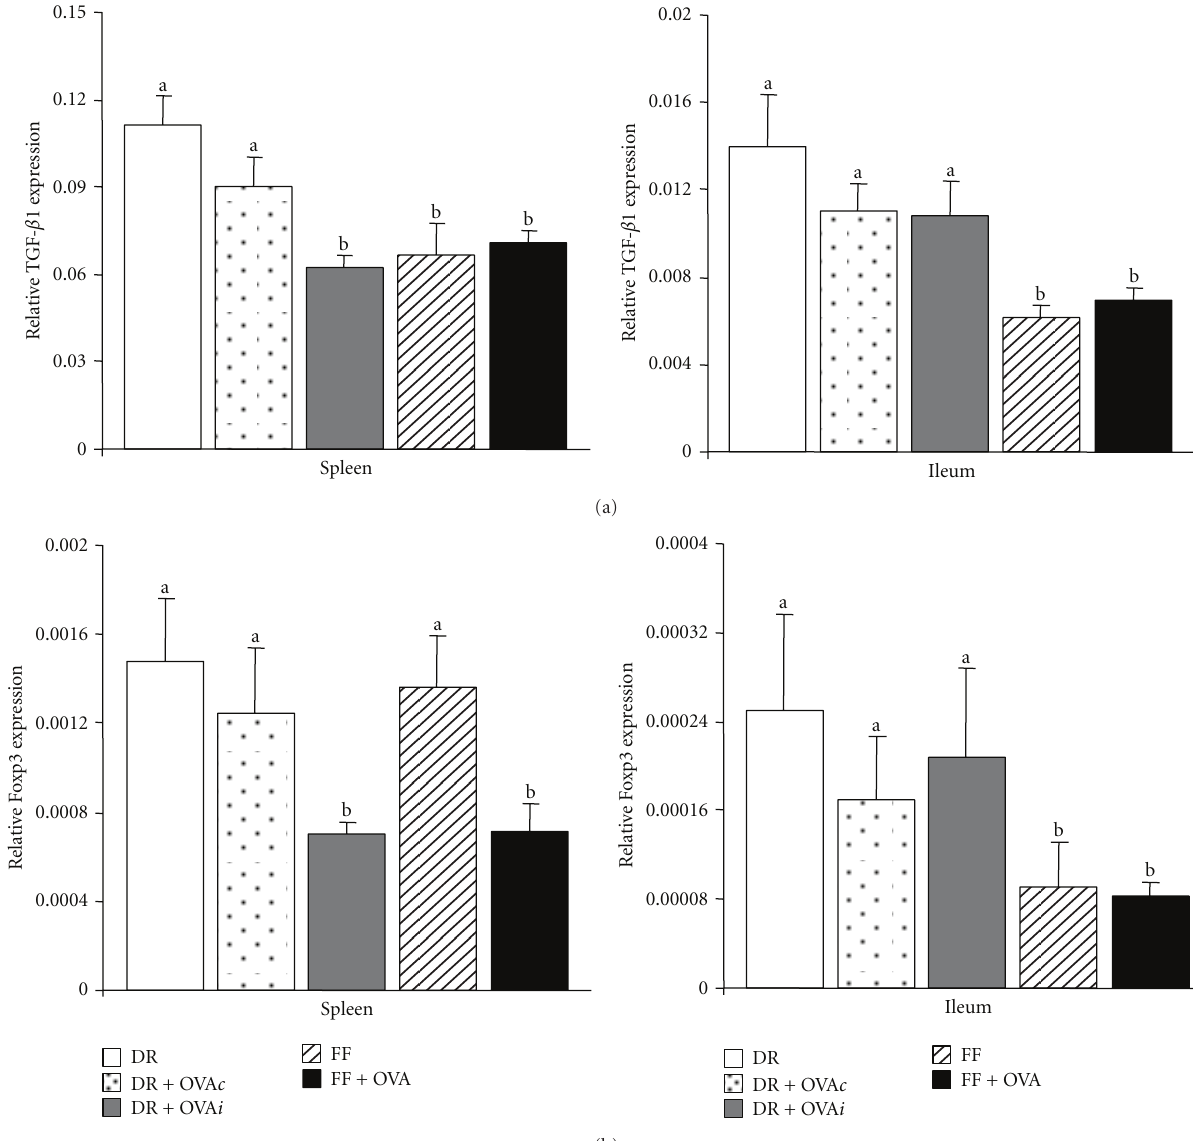
Figure 2: Splenic and ileal cytokine mRNA expression in DR and FF pups at day 14 with or without daily/intermittent treatment with OVA. TGF- β 1 mRNA (a) and Foxp3 mRNA (b) as determined by real-time PCR. Bars are mean + SEM, n = 7-8. Means without a common letter di ff er, P < 0 .